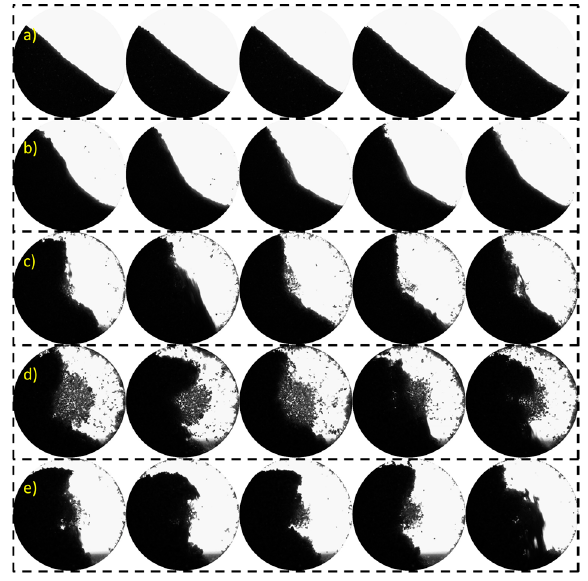
Figure 2. Five consecutive images taken by the Granudrum at 10 min − 1 for various water contents within the bulk sand w H2O : ( a ) 0% (starting material), ( b ) 0.5%, ( c ) 1%, ( d ) 3% and ( e ) 5%.